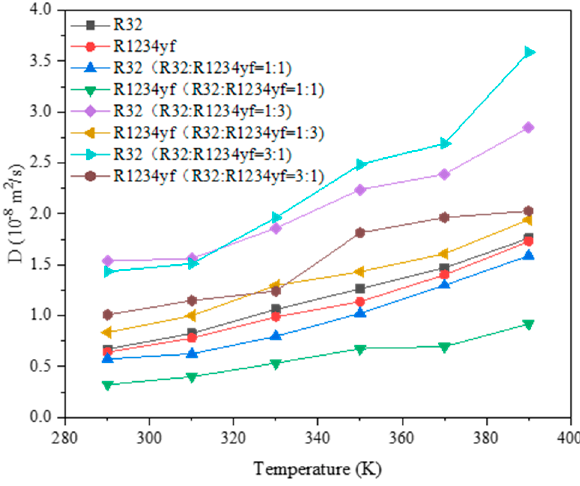
Figure 4. The self-diffusion coefficients of R32/R1234yf at different temperatures.